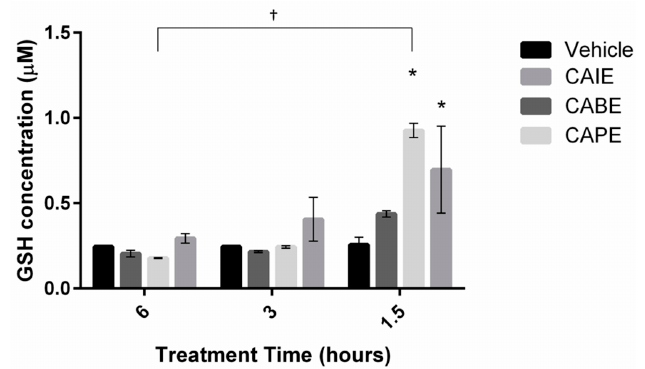
Figure 3. Quantification of intracellular glutathione (GSH) levels in the presence of three inhibitory compounds. Paenibacillus larvae were incubated in the presence of minimum inhibitory concentrations of CAIE, CAPE, CABE for up to 6 h at 37 °C. GSH levels was quantified by luminescence using a standard curve. Data presented are mean GSH (µM) ± SD ( n = 3). Asterisks represent a significant difference between control cells and cells exposed to either CAIE or CAPE ( p < 0.05). A dagger represents a significant difference over time in Paenibacillus larvae cells exposed to CAPE.